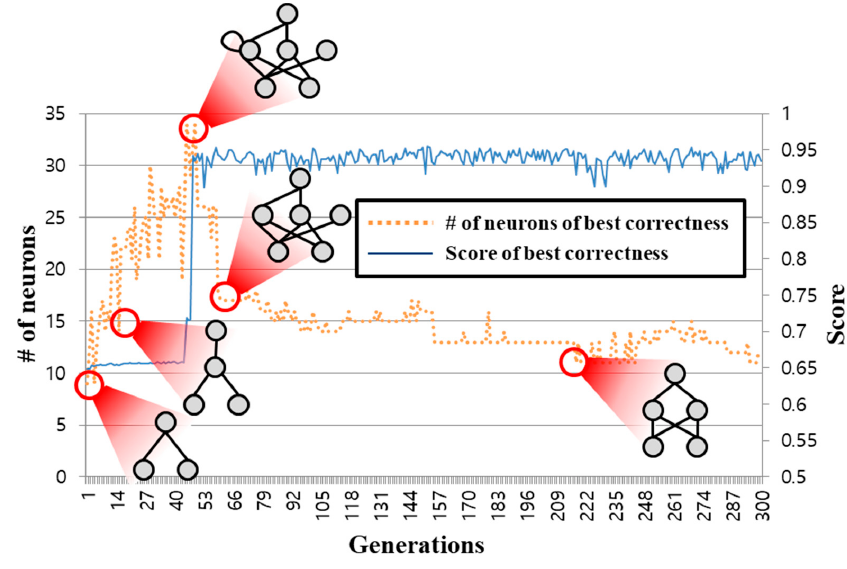
Figure 6. Simulation result of first simulation .